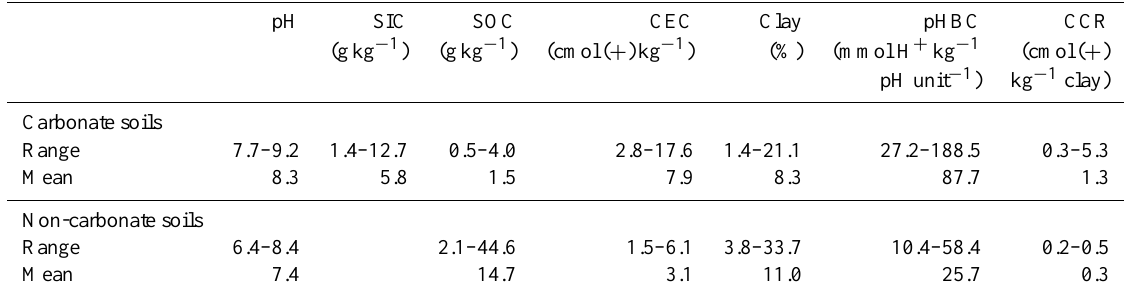
Table 1. Physicochemical properties of the carbonate-containing soils and the non-carbonate-containing soils along the transect across northern China. pH SIC SOC CEC Clay pHBC CCR (gkg − 1 ) (gkg − 1 ) (cmol( + )kg − 1 ) (%) (mmol H + kg − 1 (cmol( + ) pH unit − 1 ) kg − 1 clay) Carbonate